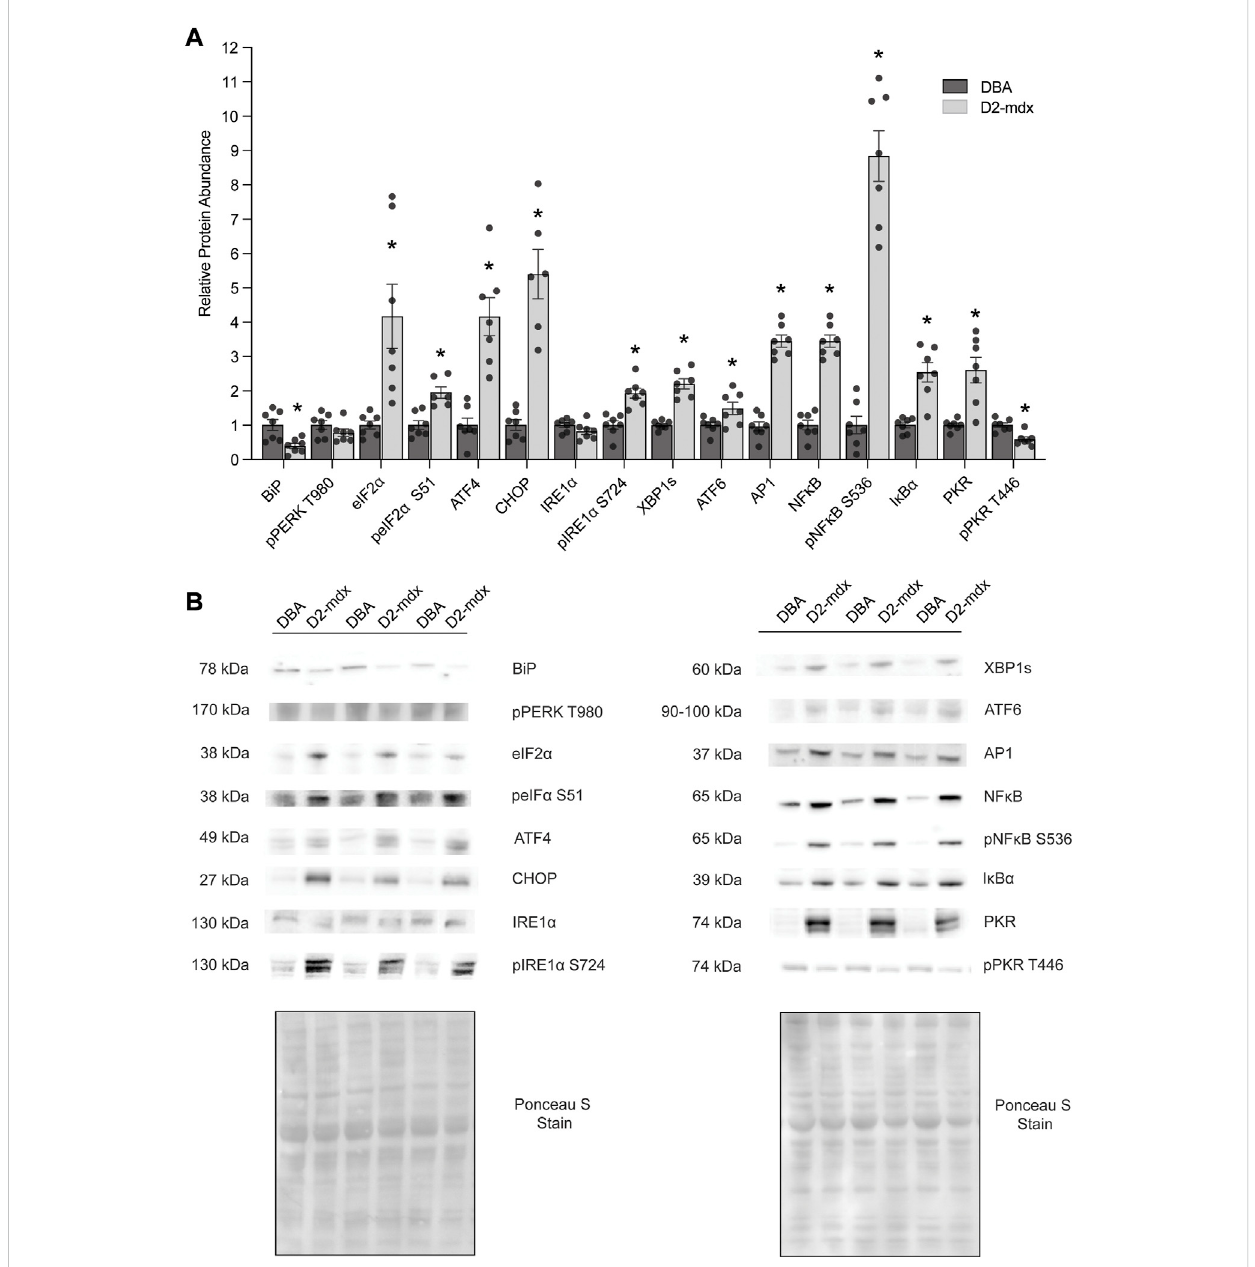
IncreasedabundanceofmarkersofERstressandtheUPRinD2-mdxmice( n =7)comparedtoDBA( n =7). (A) Increasedrelativeabundanceexcept forBiP/GRP78/HSPA5andpPKRT446(decreased),IRE1 α (similar),andpPERKT980(similar). (B) RepresentativeWesternblotandPonceauSstainimages. Unpaired t -test used for statistical analysis. Signi fi cance established at p <